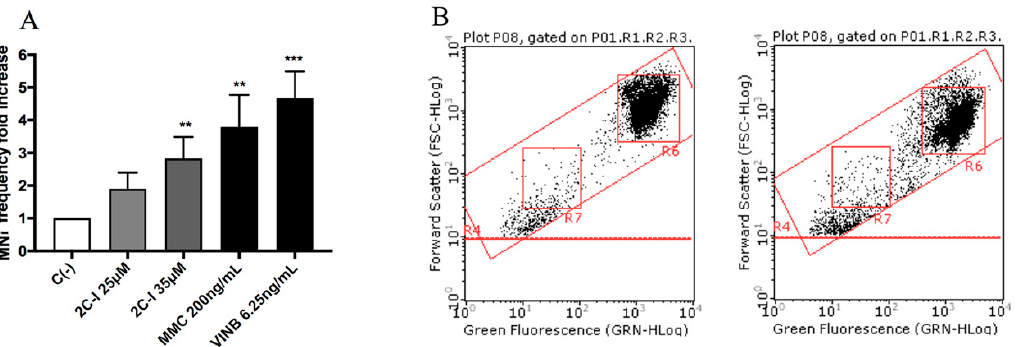
Figure 4. The MNi frequency fold increase on TK6 cells after 26 h of treatment with 2C-H at the indicated concentrations with respect to the untreated negative control C (-) and to positive controls [MMC and VINB]. ( A ) A plot of the nuclei and MNi in the untreated control ( B , left), and in 35 µM 2C-H-treated cultures ( B , right). Each bar represents the mean ± SEM of five independent experiments. Data were analysed using repeated ANOVA followed by the Bonferroni post-test. ** p < 0.01 vs C (-); *** p < 0.001 vs C (-).